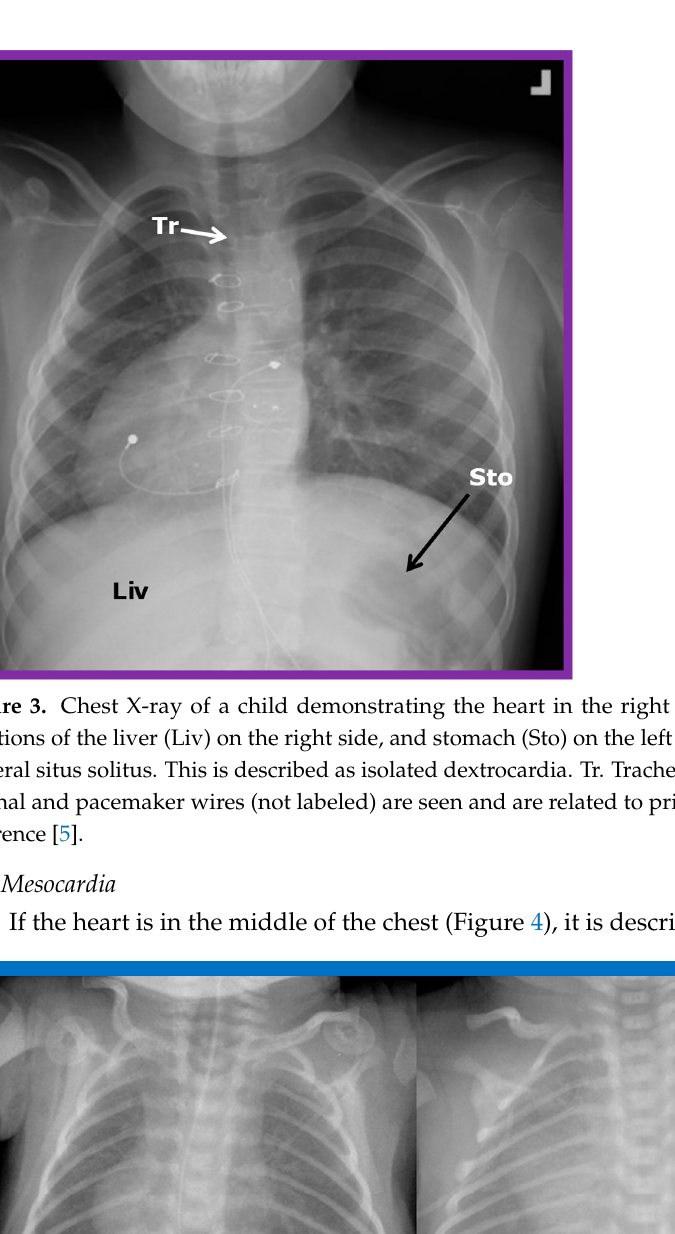
dextrocardia. ( A ) The liver (Li) is visualized across the abdominal cavity without seeing the stomach air bubble; thus, it is not possible to establish the visceral situs. ( B ) On the other hand, the stomach